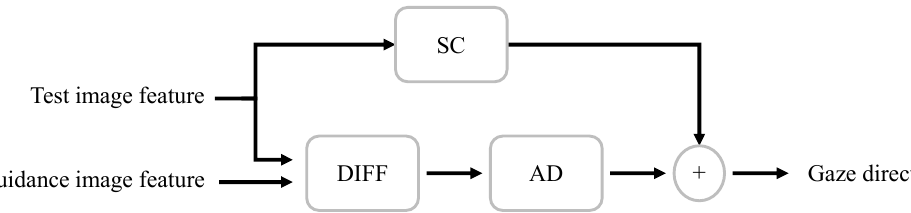
Figure 5. DRNet residual structure. The guidance image and the test image features are extracted from the raw inputs. The sum of SC and AD outputs provides the gaze